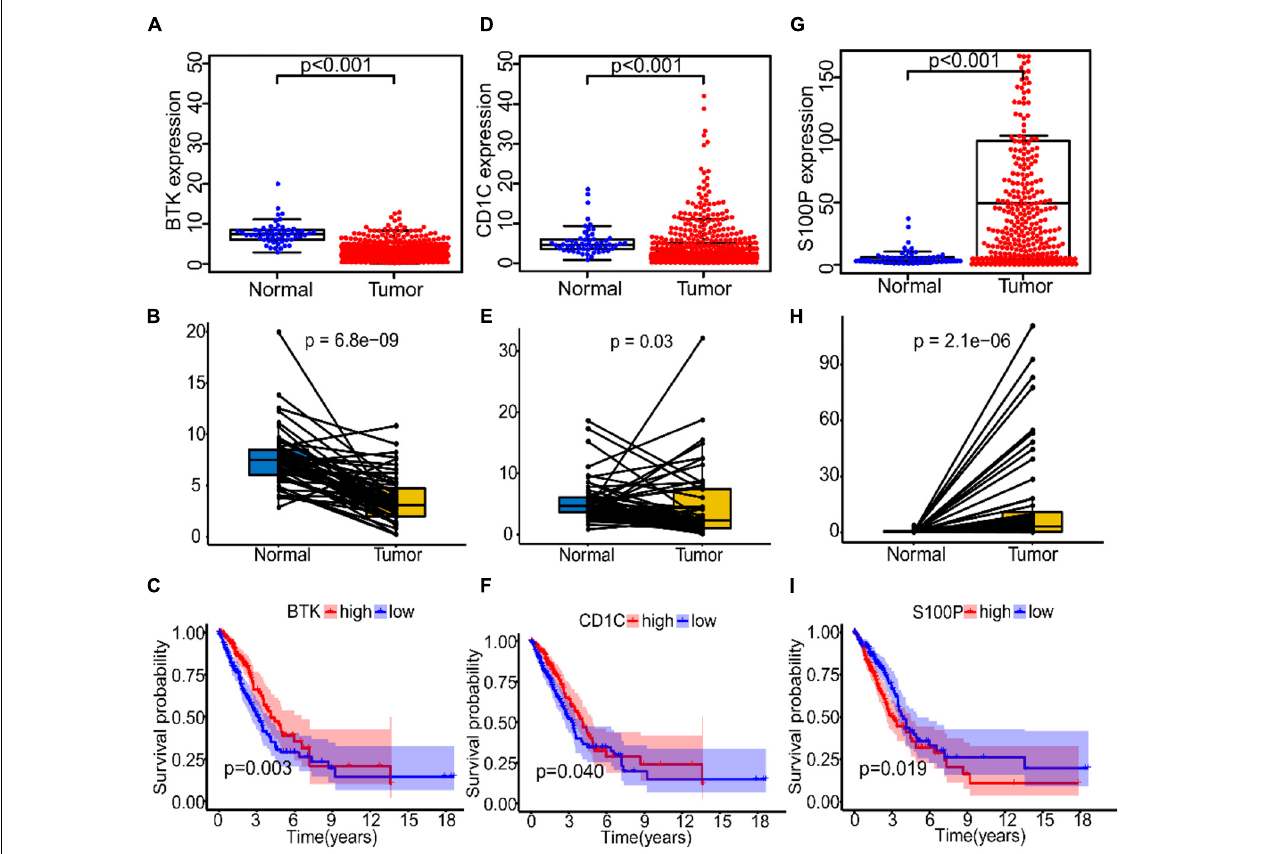
FIGURE 6 | The expression and prognostic analysis of three immune genes in LUAD patients. (A–C) The correlation between the expression level of BTK in normal and tumor tissues and prognosis of patients. (D–F) The correlation between the expression level of Cd1c in normal and tumor tissues and prognosis of patients. (G–I) The correlation between the expression level of S100P in normal and tumor tissues and prognosis of